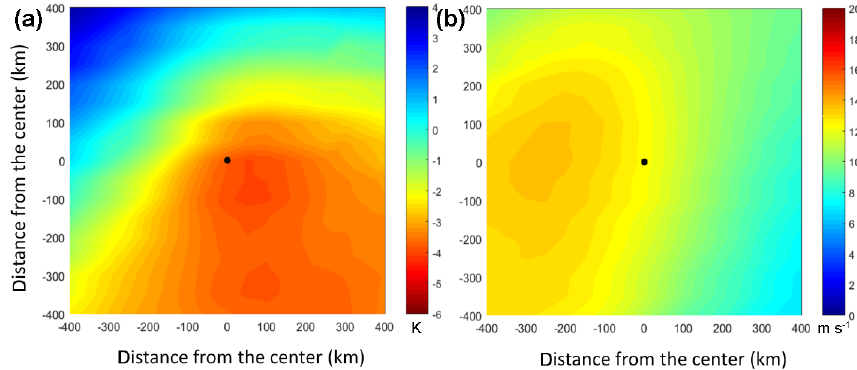
Figure 6. Composite analyses showing the average values of (a) SLI and (b) DLS from ERA-Interim in moving spatial windows centered at the track location (center) for all 985 HS events between 2005 and 2014 (SHY; see Fig. 1).